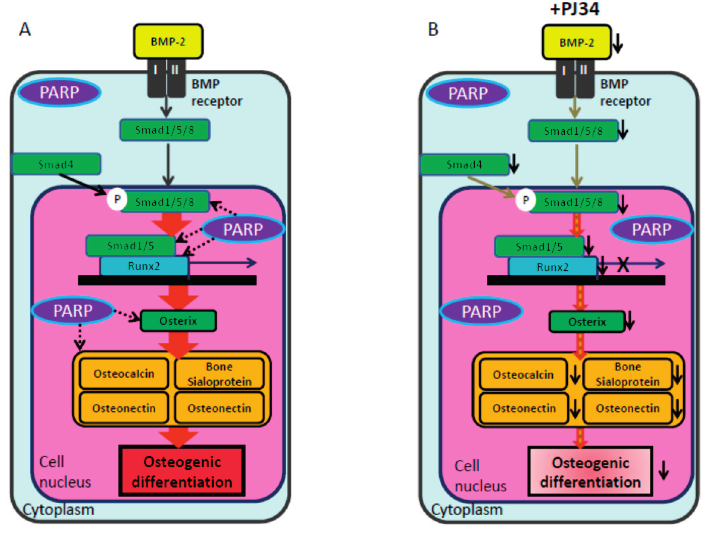
Figure 10. Schema of osteogenic differentiation through the BMP signaling pathway and possible regulation by PARP activity. ( A ) BMP-2 activates Smad1/5/8 (dark gray arrows) and upregulates Runx2 transcription to promote osteogenic differentiation. Runx2 induces expression of Osterix and accelerates transcription of Osteocalcin , Bone Sialoprotein , Osteonectin , and Osteopontin (brown thick arrows). PARP activity may also be involved in this pathway (black dotted arrows). Dotted lines are based on the results of this report; ( B ) PJ34 is suggested to suppress BMP-2 and Smad4 signaling (light gray arrows), leading to attenuation of mRNA levels for these factors (diagonal stripe arrows) and subsequent decrease in osteogenic